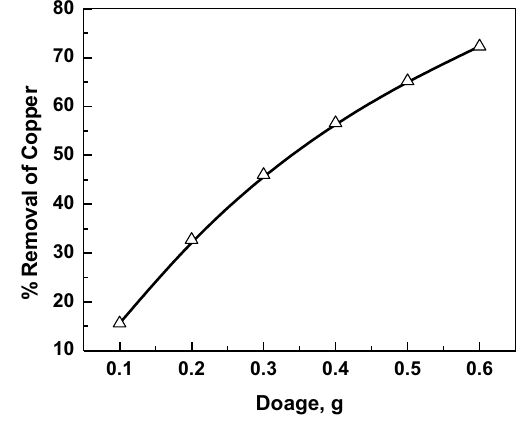
Fig. 8 Effect of variation in